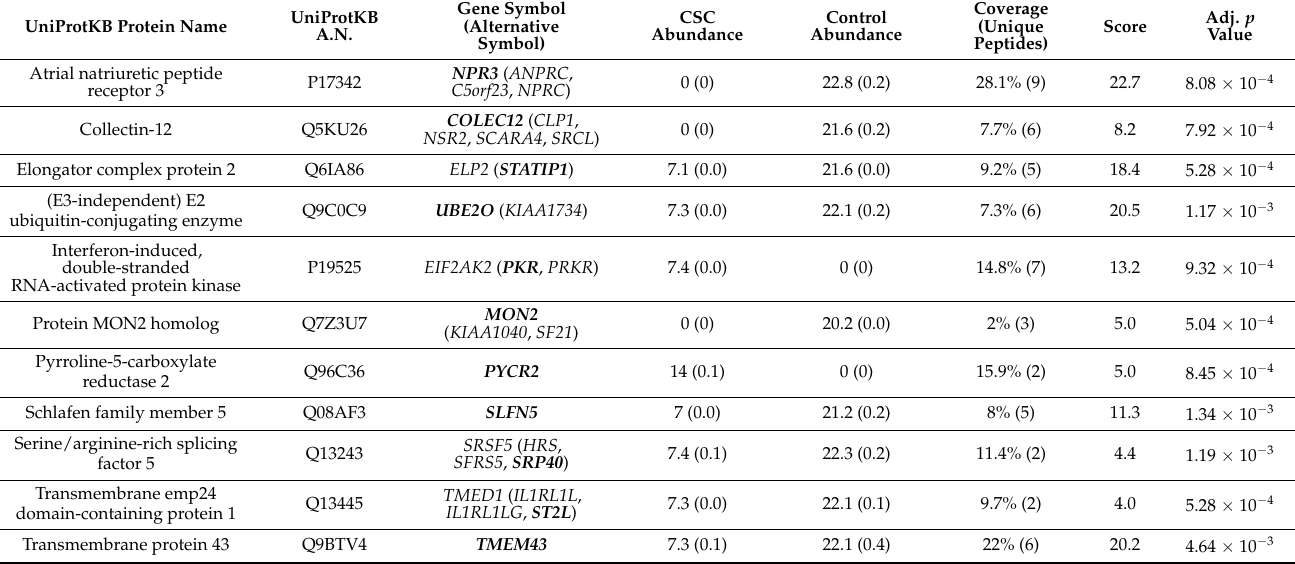
Table 1. Differentially abundant proteins, detected/identified using LC–MS/MS analysis,